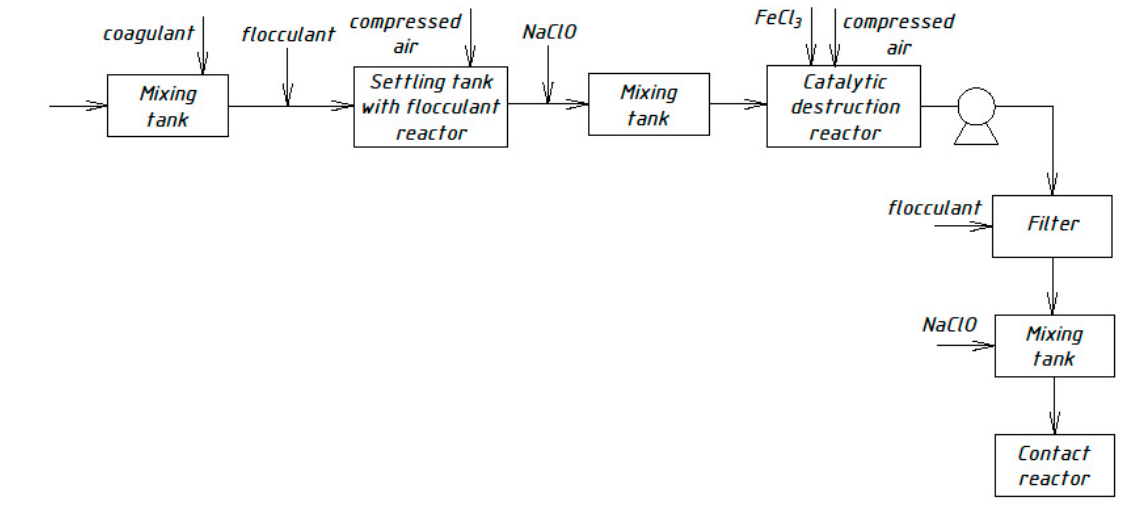
Figure 7. Wastewater treatment scheme with a catalytic destruction reactor.